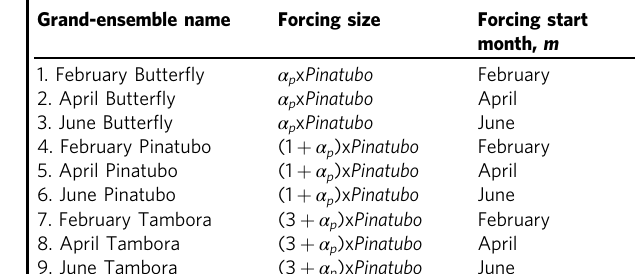
Table 3 Summary of the perturbed 100-member grand- ensemble simulations for each ENSO onset listed in Table 2: La Niña, Neutral, weak El Niño, moderate El Niño, strong El Niño, and extreme El Niño.